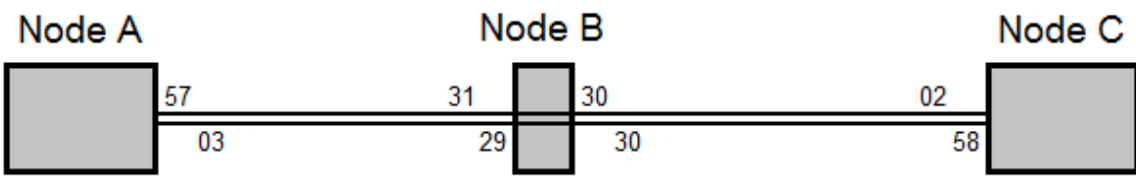
Figure 6. Extended timetable descriptors example – 30 min interval.